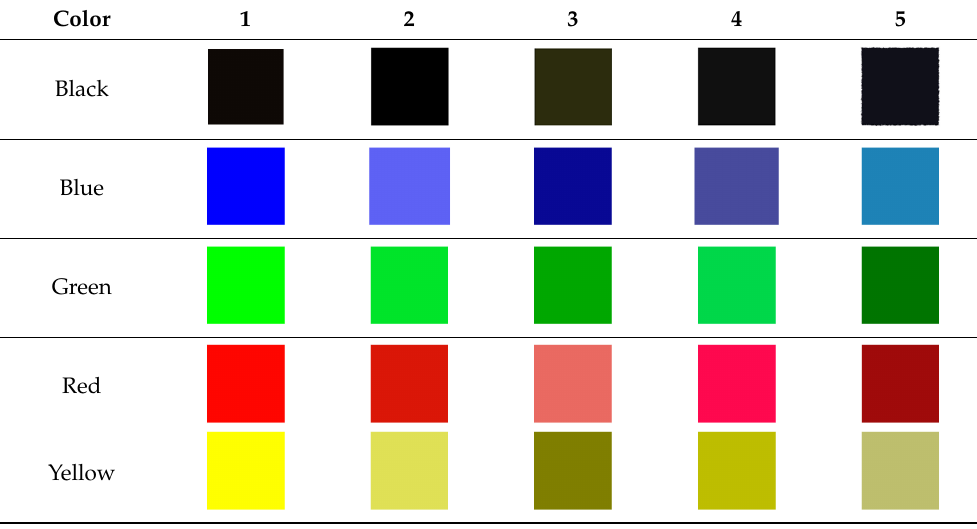
Figure 3. Training base. Samples produced using TensorFlow library. Next, a pure artificial neural network model was produced and training parameters were set, such as learning patience (in the absence of performance improvement in the